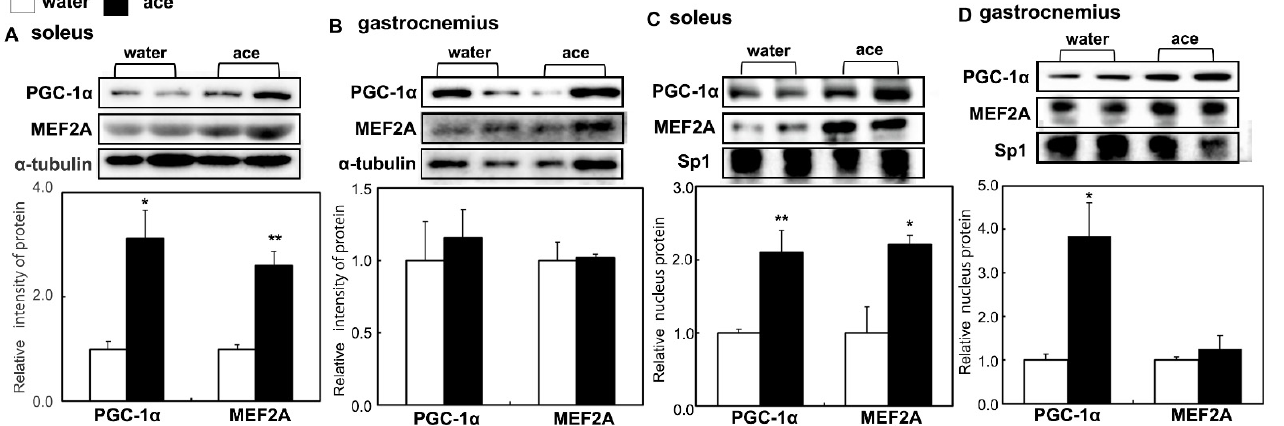
Figure 5. Effects of long-term supplementation of acetic acid on the expression of peroxisome proliferator-activated receptor-gamma coactivator 1 alpha (PGC-1 α ) and myocyte enhancer factor 2A (MEF2A) proteins in the soleus ( A ) and gastrocnemius ( B ) muscles and the nuclear localization of PGC-1 α and MEF2A in the soleus ( C ) and gastrocnemius ( D ) muscles of SD rats at 56 weeks of age in the water and acetic acid (ace) groups. Values represent means ± SE for 4 – 5 rats. * p < 0.05, ** p < 0.01, statistically significant versus the value of water group. Results were analyzed with Student’s t -test.